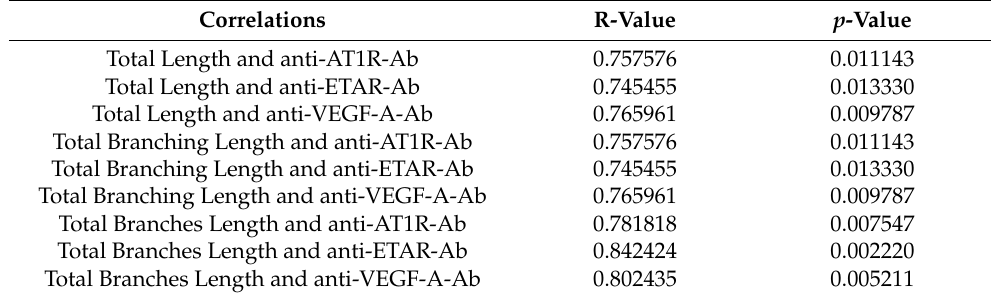
Table 5. Correlations between parameters of angiogenesis in vitro and non-HLA